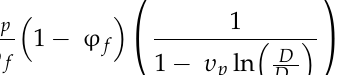
Figure 9. Interfacial free volume fraction for Neat/GFRP, MWCNTs/GFRP, and CNFs/GFRP composites at temperatures 22 and 45 °C.